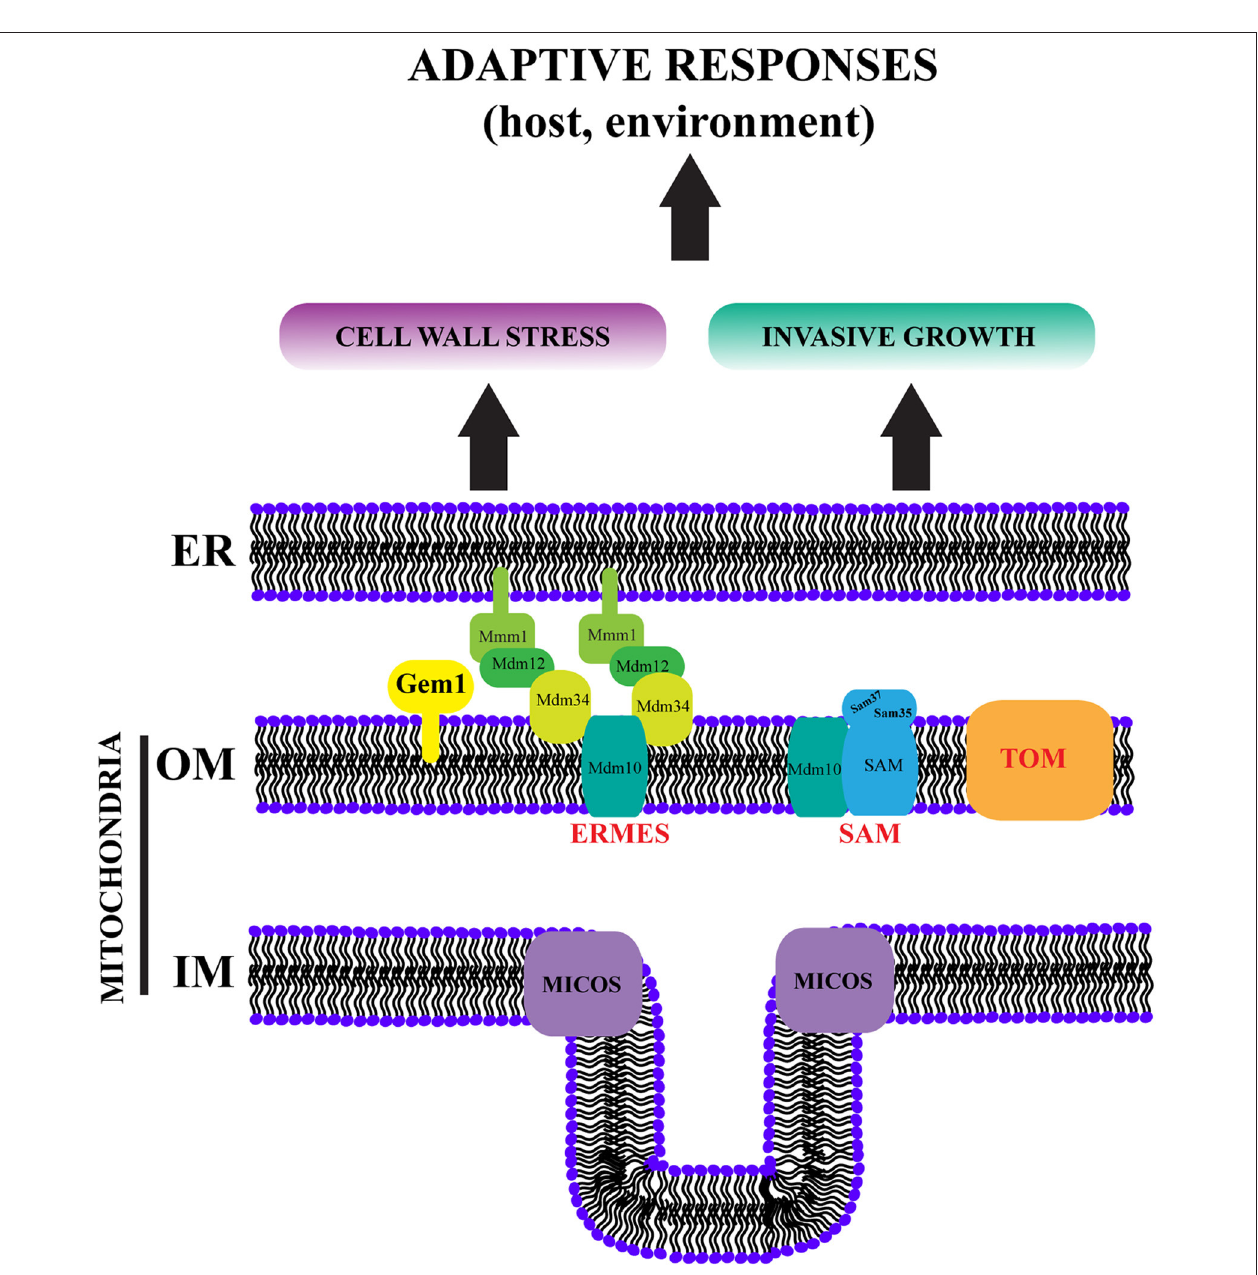
FIGURE 7 | ERMIONE controls virulence behaviors in pathogenic fungi. In S. cerevisiae an ER-Mitochondria Organizing Network (ERMIONE) has been proposed to consist of the ERMES, SAM, TOM and MICOS complexes (shown here), and additional mitochondrial and ER proteins and complexes, as well as the vacuole-mitochondria tether vCLAMP, which are not depicted here for simplicity (van der Laan et al., 2012; Wideman and Muñoz-Gómez, 2016). ERMIONE is proposed to be a central hub for orchestrating mitochondrial biogenesis, lipid homeostasis, organelle dynamics and inter-organellar interactions. Based on our studies of Gem1 (this study), as well as the SAM and ERMES complexes in C. albicans (Qu et al., 2012; Tucey et al., 2016), and the study of ERMES in A. fumigatus (Geißel et al., 2017), we propose that ERMIONE plays a crucial role in the environmental adaptation of pathogenic fungi, which ultimately drives their virulence by controlling stress responses and invasive growth. Therefore, disruption of ERMIONE holds promise as antifungal therapy. ER: endoplasmic reticulum, OM: outer membrane, IM: inner membrane